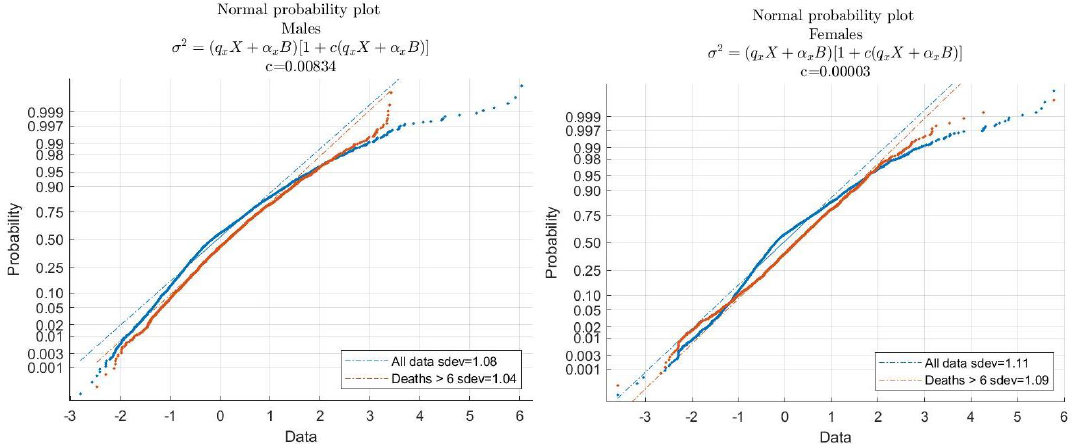
Figure 8. Normal probability plot—negative